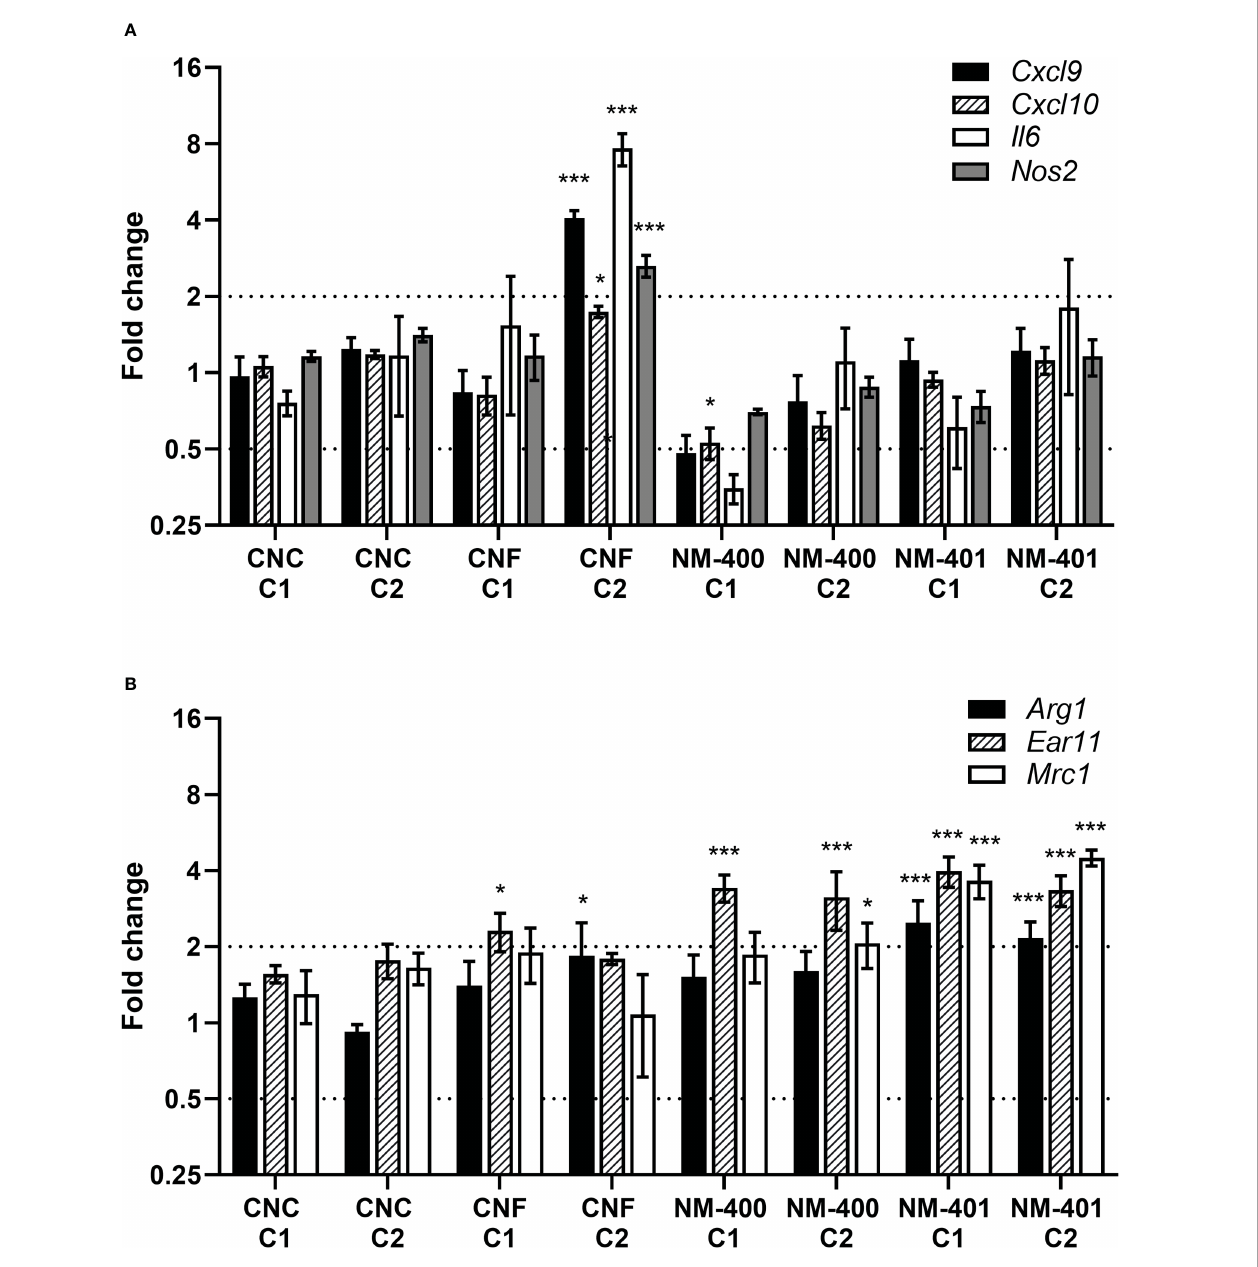
FIGURE 3 Effects of nanomaterial exposure on the expression of common macrophage polarization markers. Changes in gene expression were assessed by qPCR following exposure to CNC, CNF, NM-400 and NM-401 in (A) M1 and (B) M2 macrophages. C1: 0.15 m g/cm 2 and C2: 2.7 m g/cm 2 . Expression was related to the mean expression in unexposed control cells which was set to 1. Data represent mean ± SE, (n=5), *p<0.05,